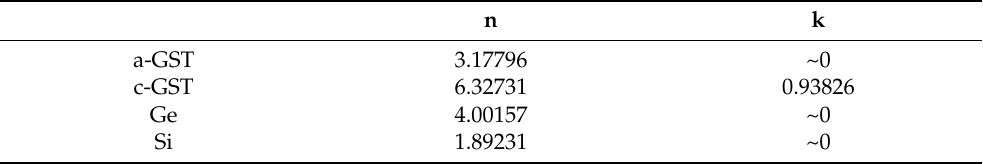
Table 1. Material parameters used in